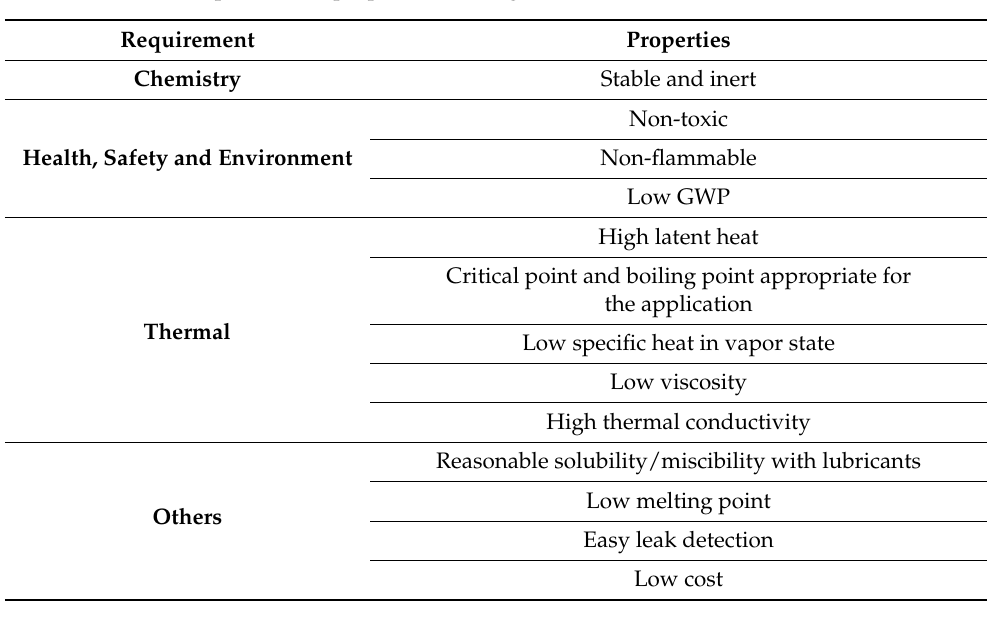
Table 2 specifies a set of proper properties of refrigerants [35]. Table 2. Desirable requisites and properties of